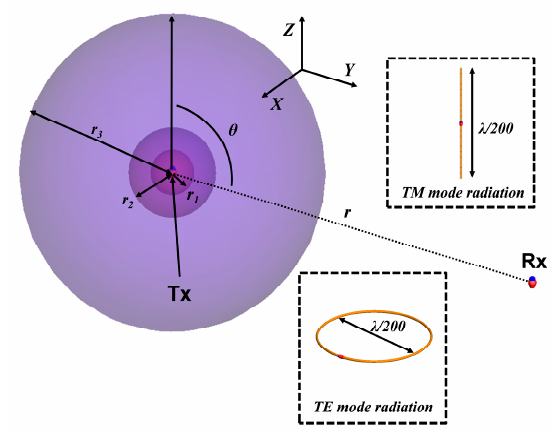
Figure 2. FEKO simulation setup for verification of the derived solution.